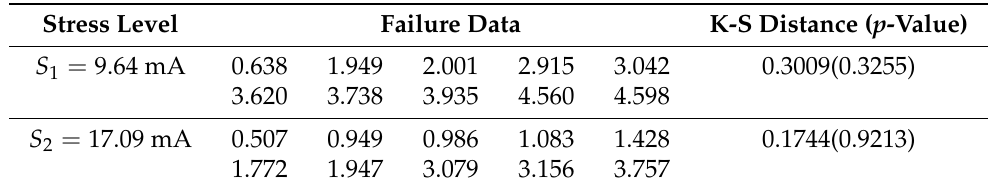
Table 11. WOLED data, K-S statistic, and the corresponding p -value. Stress Level